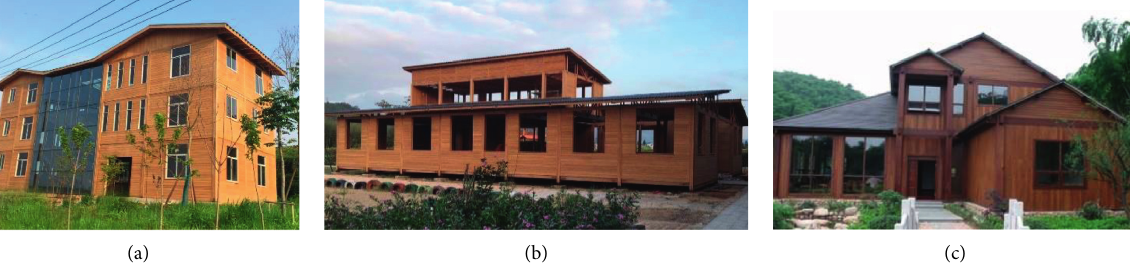
Figure 1: Examples of EBC structure.